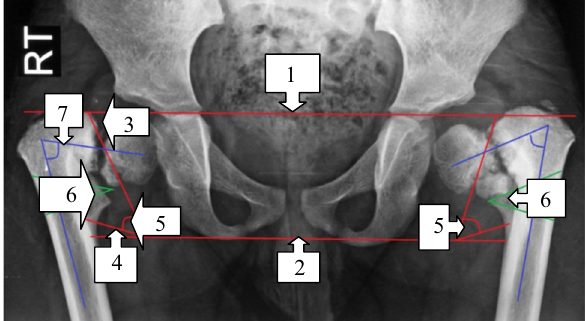
Fig. 3 Analyzing the deformity and planning the procedure. 1 Hilgenreiner line, (line through both triradiate cartilages). 2 Inter- ischial line. 3 Hilgenreiner epiphyseal angle (HEA). 4 The fixed angle (16 (cid:3) ) that is subtracted from the Hilgenreiner epiphyseal angle (HEA). 5 The actual osteotomy angle (angle of correction); angle 5 = angle 3 - angle 4 . 6 The angle between the green lines represents the actual angle of the corrective osteotomy; angle 6 = angle 5 . 7 Line bisecting the neck of the femur that is used when planning the upper line of the